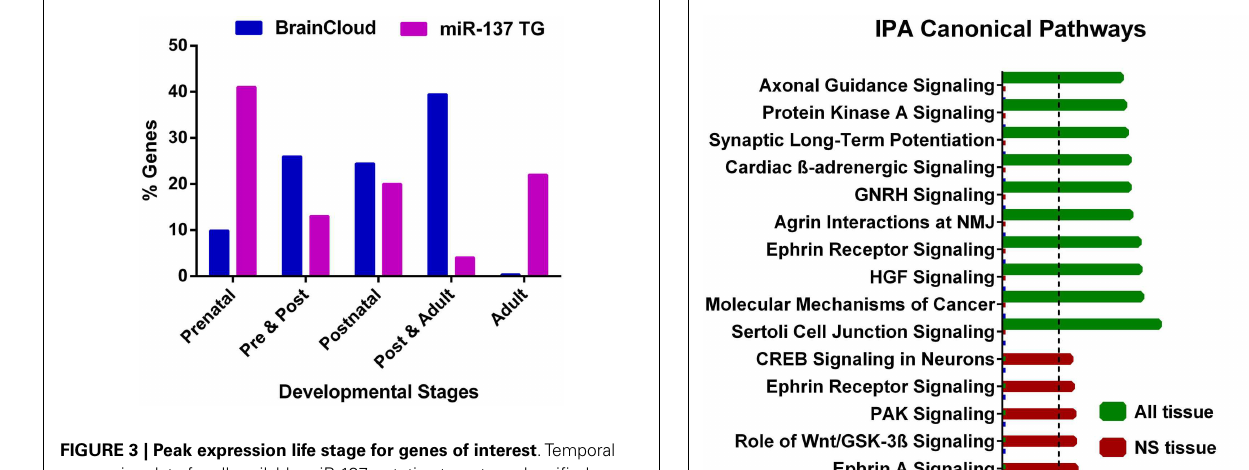
FIGURE 3 | Peak expression life stage for genes of interest .Temporal expression data for all available miR-137 putative targets and verified targets is based on the BrainCloud Database (Kang et al., 2011). Comparison of the temporal expression profiles of miR-137 targets and whole brain transcriptome (BrainCloud) using Chi square analysis revealed that the temporal expression profile frequency distributions were significantly different ( p < 0.01).The prenatal stage is defined as week 14 through birth, post-natal stage is defined as birth through age 20years, and adult stage is defined as age 20years and older.